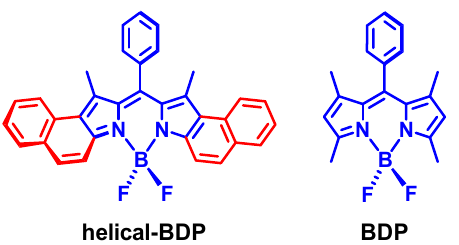
Figure 7. Molecular structures of a twisted Bodipy derivative showing efficient ISC (helical-BDP) and a typical native Bodipy compound (BDP).